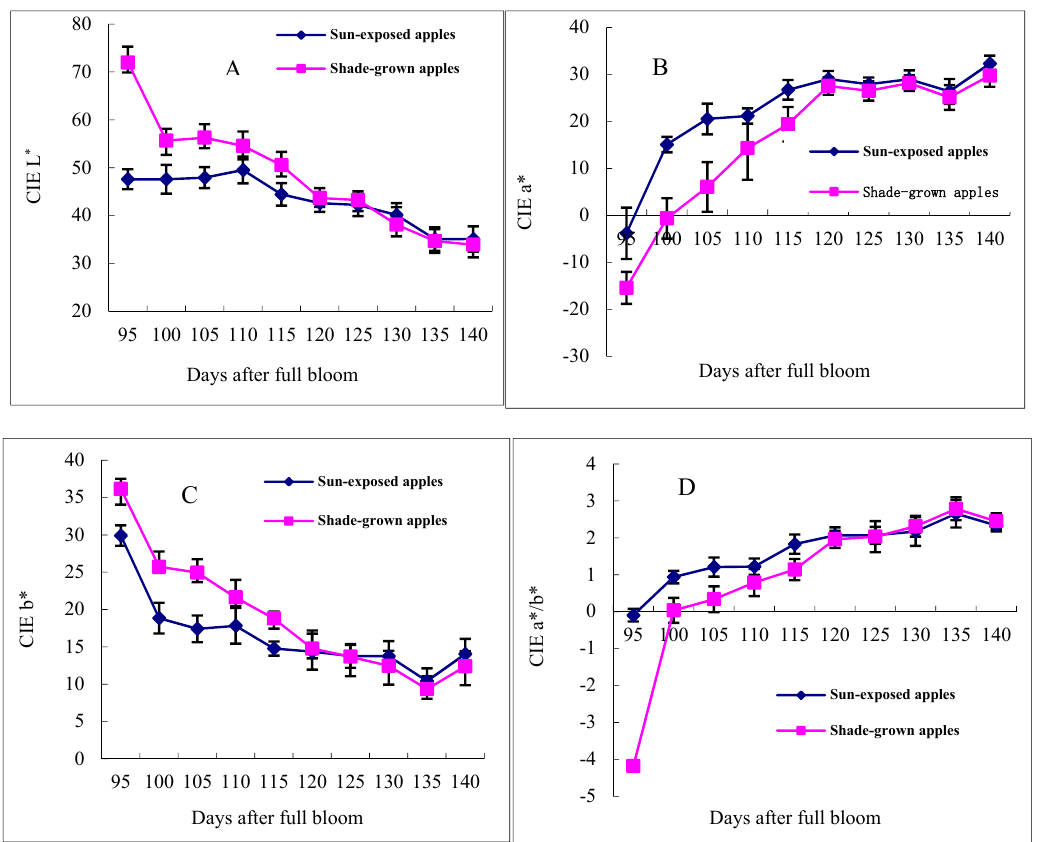
Figure 1. CIE parameters of “Starkrimson” during the ripening period.